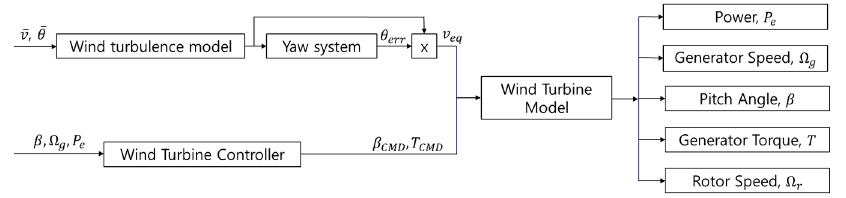
( b ) Figure 4. Terrain model of the target wind farm L ( a ) elevation; ( b ) roughness length. The size and grid spacing of the terrain model has an impact on the prediction results of the power output [19]. Therefore, in this study, the size of the terrain model was determined to be 10 km by 10 km, and the horizontal grid spacing was 25 m by 25 m. The number of vertical grids was 40, and the number of grids below the wind turbine hub height was six, to accurately simulate the wind characteristics in the wind farm. The wind field analysis was carried out using WindSim based on the Reynolds-Averaged Navier–Stokes (RANS) equation. Because the equation is nonlinear, the solution is solved with the use of multiple iterations until convergence is obtained [20]. This study uses the GCV (Convergence control with new solver) solver in the CFD simulation WindSim to solve the RANS equation. The GCV method uses a pressure-based separation solver strategy to control the mass flux on the control- volume faces, providing faster convergence [21]. It was assumed that the atmospheric boundary layer had a height of 500 m, that the atmospheric flow was stable, and that the wind speed above 500 m was constant with height [22]. The boundary condition at the top was “fixed pressure”. The turbulence model used was the standard k- ε eddy viscosity turbulence model without considering temperature changes, where k is the turbulent flow energy and ε is the rate of turbulent dissipation. Based on the results of the wind field analysis and the N.O. Jensen wake model [23], the 10-min averaged wind speed, wind direction, and electrical power of the target wind turbine were obtained from WindSim. 2.4. The Wind Turbine Matlab/Simulink Dynamic Model with a Wind Turbine Controller In this study, the dynamic simulation model of a wind turbine was used for the prediction of the electrical power production by the target wind turbine. The model was developed in the previous study and modified for this study to be used to predict the power of an actual wind turbine [15]. Figure 5 shows the schematic of the dynamic model used for the target wind turbine. The